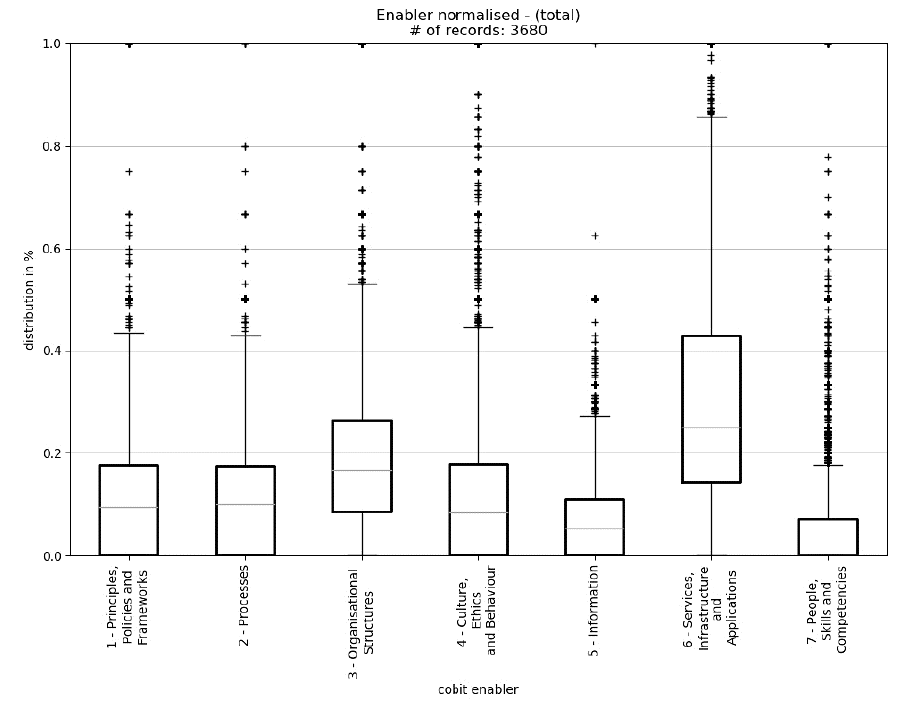
Figure 2. Histogram for all candidate characteristics with all COBIT dimensions